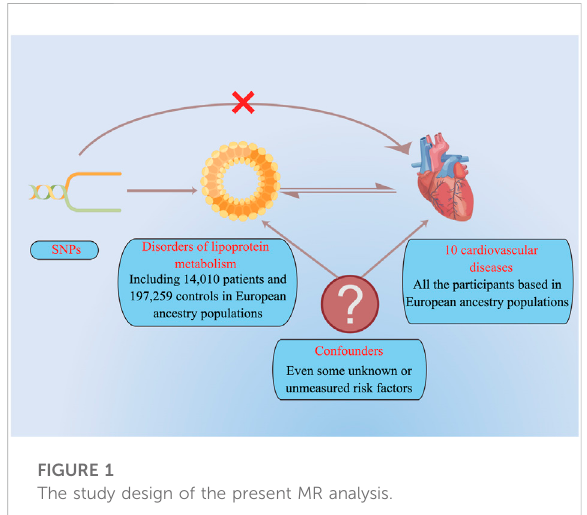
FIGURE 1 The study design of the present MR